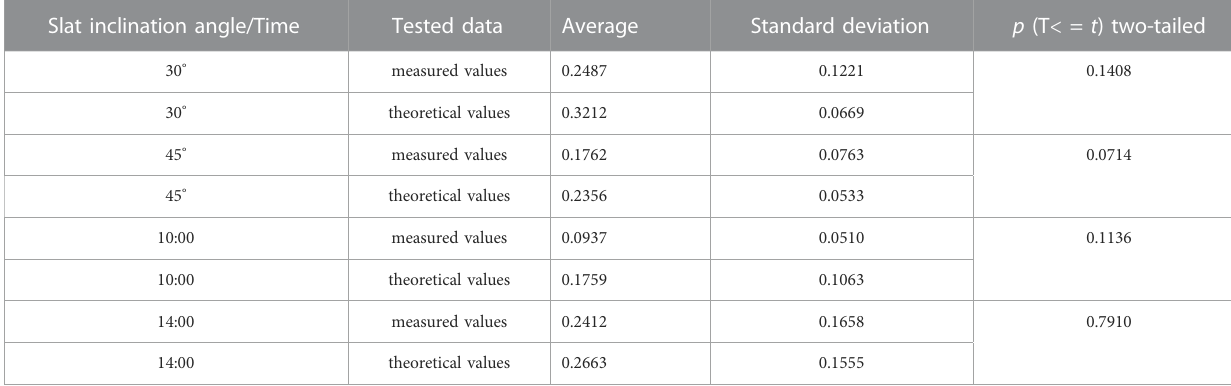
TABLE 1 Test results of signi fi cant difference between theoretical results and measured data. Slat inclination